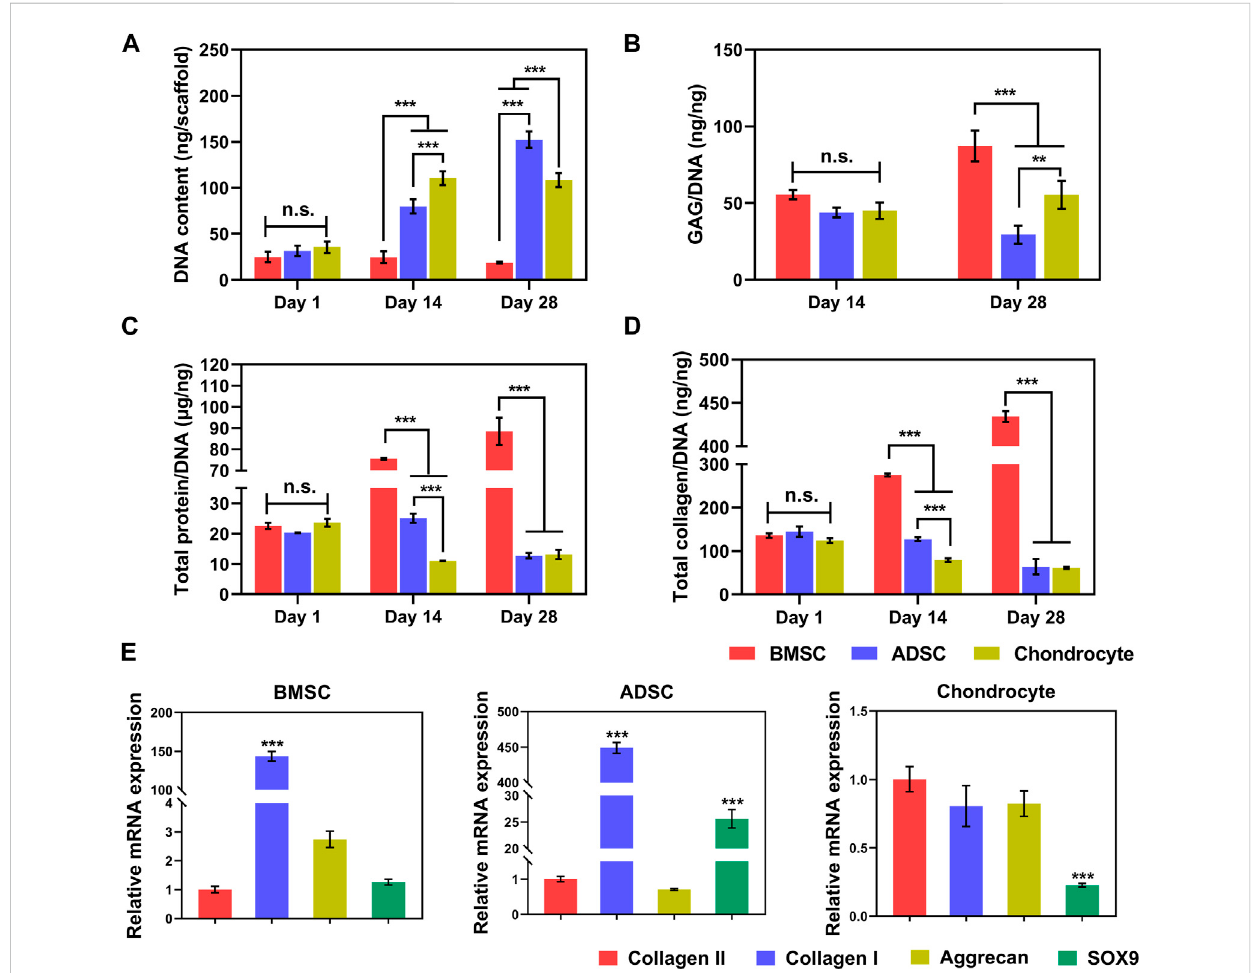
FIGURE 4 Biochemistry and gene expression of cells on scaffolds. Increased total DNA contents indicate steady cell proliferation (A) . At per cell level, BMSC produces signi fi cantly greater GAG (B) , total protein (C) , and collagen (D) than ADSC and chondrocyte. BMSC and ADSC show predominate collagen I expression, in contrast, chondrocyte maintains high level of collagen II expression (E) . * p < 0.05, ** p < 0.01, *** p <